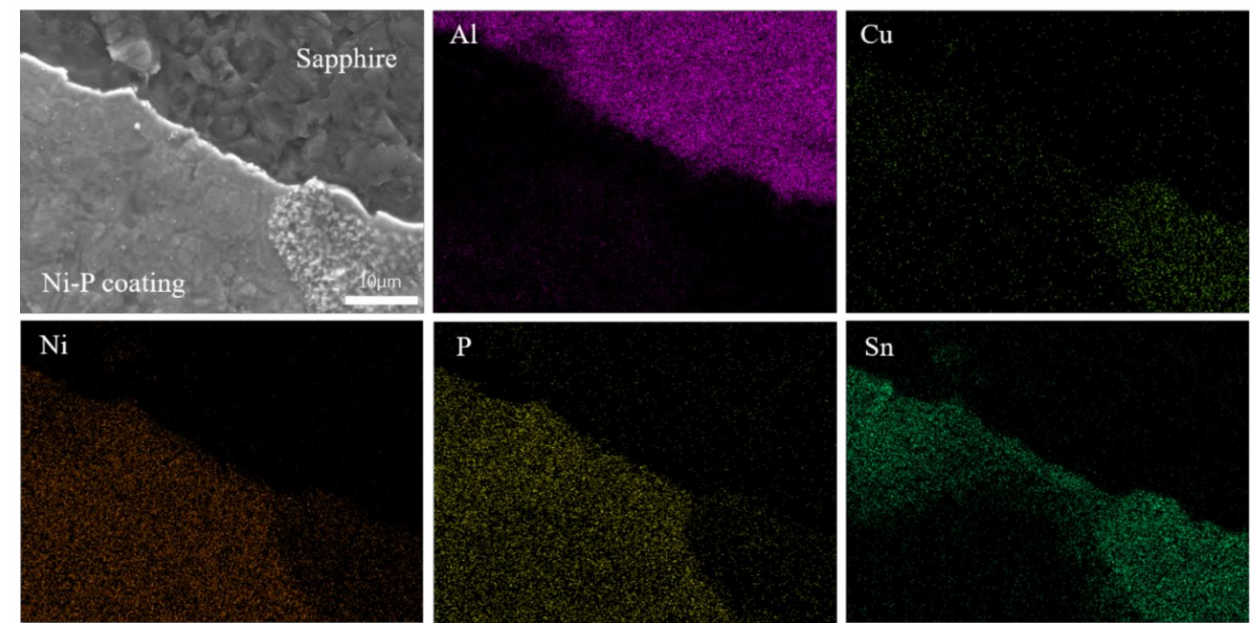
Figure 8. Element analysis diagram of fracture surface morphology.